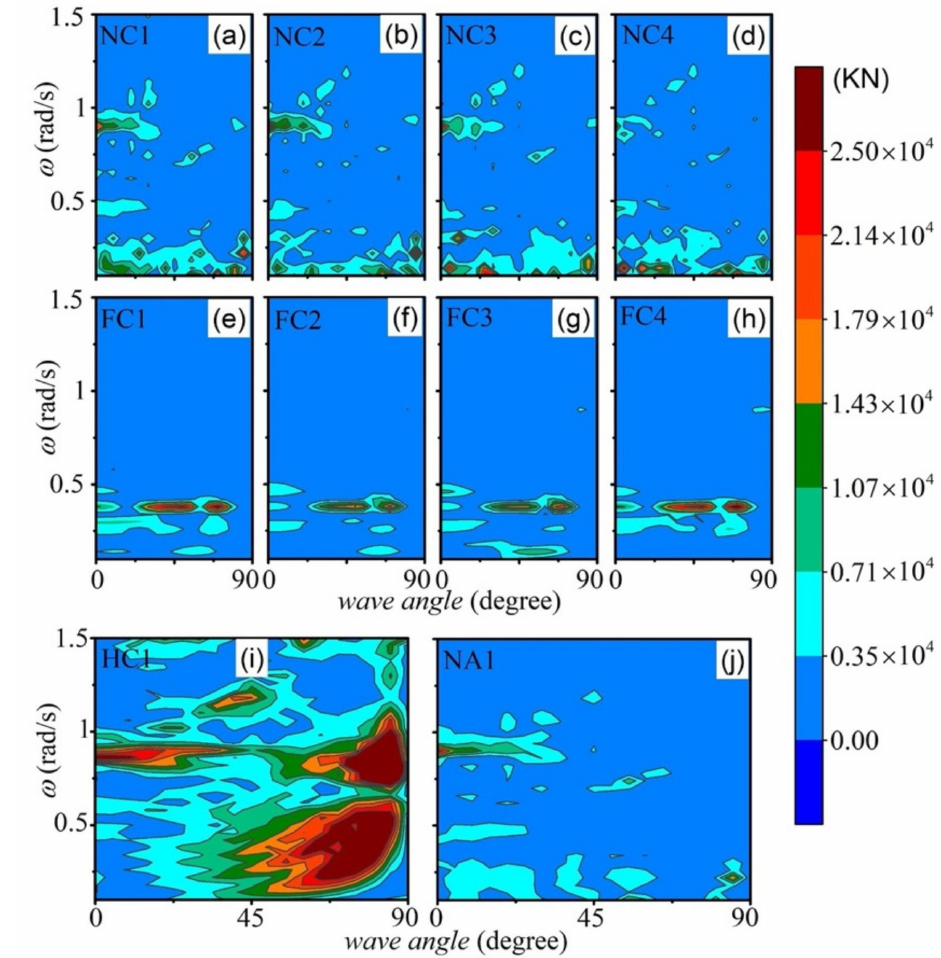
Figure 10. The cloud charts of ( a – d ) the novel connector load of the first connector of all four groups (FC1–FC4), ( e – h ) the flexible connector load of the first connector of all four groups (NC1–NC4), ( i ) the hinged connector load (HC1) between the first and second module, and ( j ) the actuator output force of the first novel connector in the first group (NA1) in a domain spanned by the wave frequency and wave incident